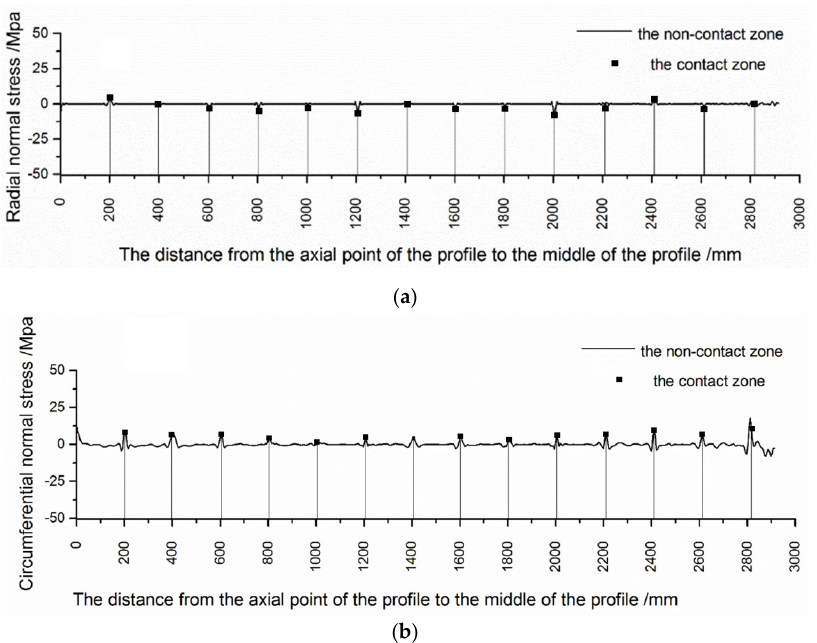
Figure 9. The radial normal stress and circumferential normal stress; ( a ) the radial normal stress along path a; ( b ) the circumferential normal stress along path a.